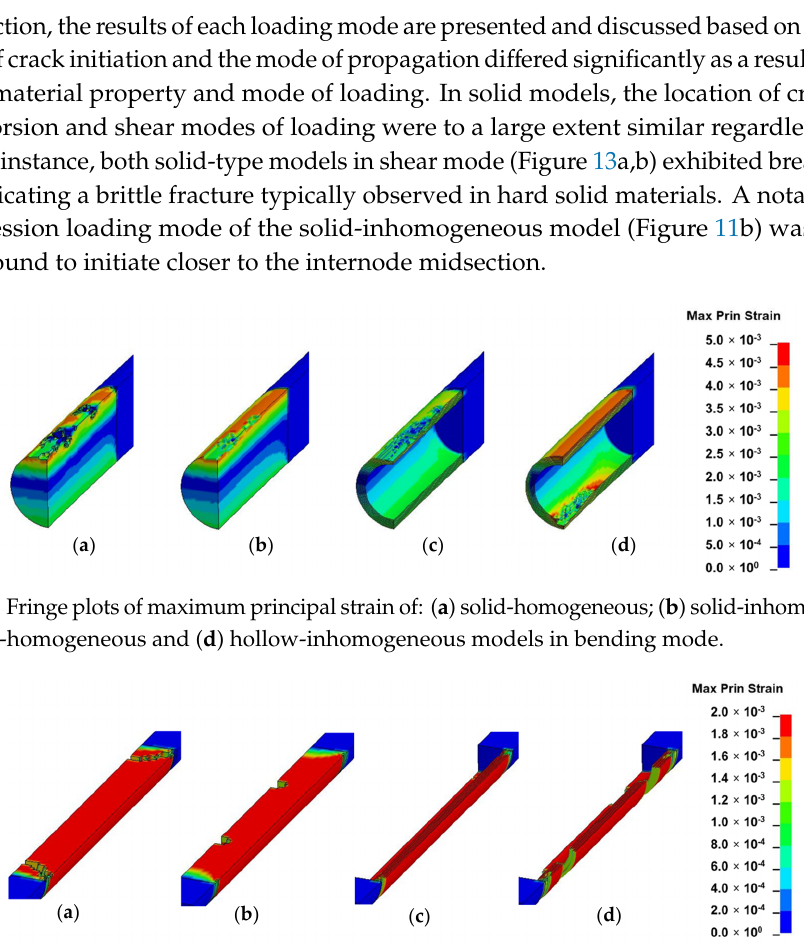
Figure 9. Schematic of boundary conditions of external loading conditions: ( a ) bending mode; ( b ) torsion mode; ( c ) compression mode and ( d ) shear mode.